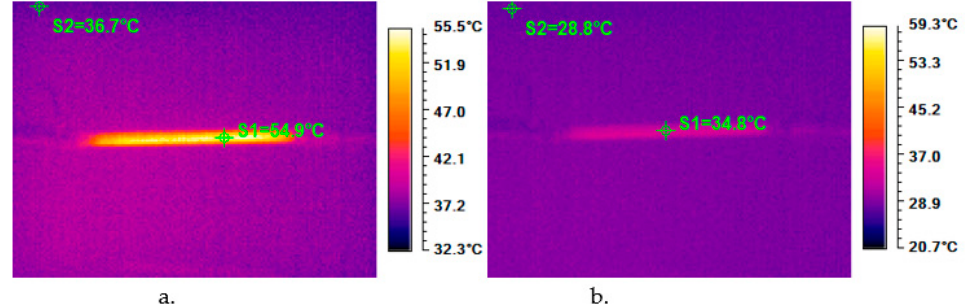
Figure 3. Temperature distribution on the nitinol spring recorded with a thermal imaging camera: ( a ) operating period; ( b ) rest period.